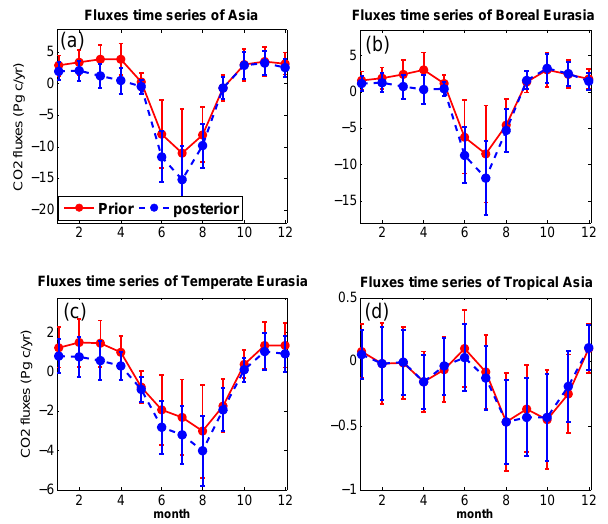
Figure 6. A priori and posteriori averaged fluxes (with uncertain- ties) over Asian regions during the period 2006–2010 are listed as follows: (a) Asia; (b) boreal Eurasia; (c) temperate Eurasia; (d) tropical Asia. This flux is biosphere carbon sink after removal of fossil and biomass-burning fluxes.